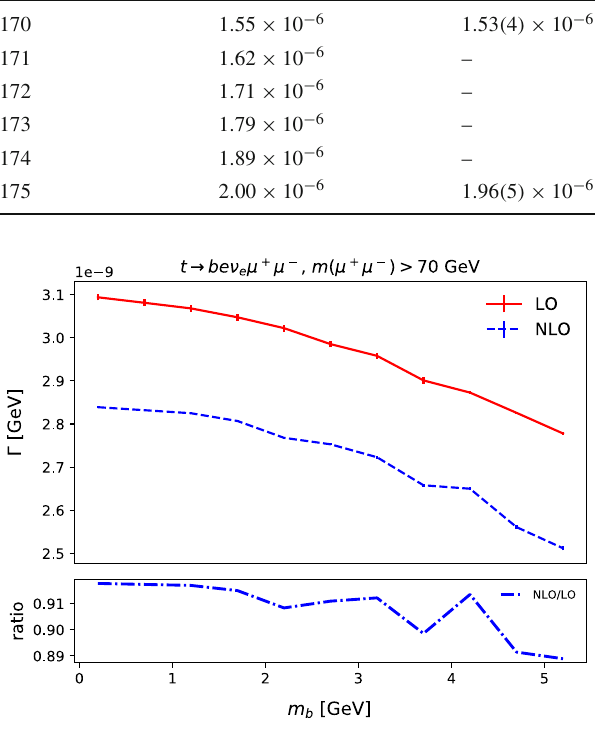
Fig. 1 The decay width of the process t → be + ν e μ + μ − for m (μ + μ − ) > 70 GeV at leading order and next-to-leading order in QCD as a function of the bottom quark mass. The lower inset shows the ratio of NLO to